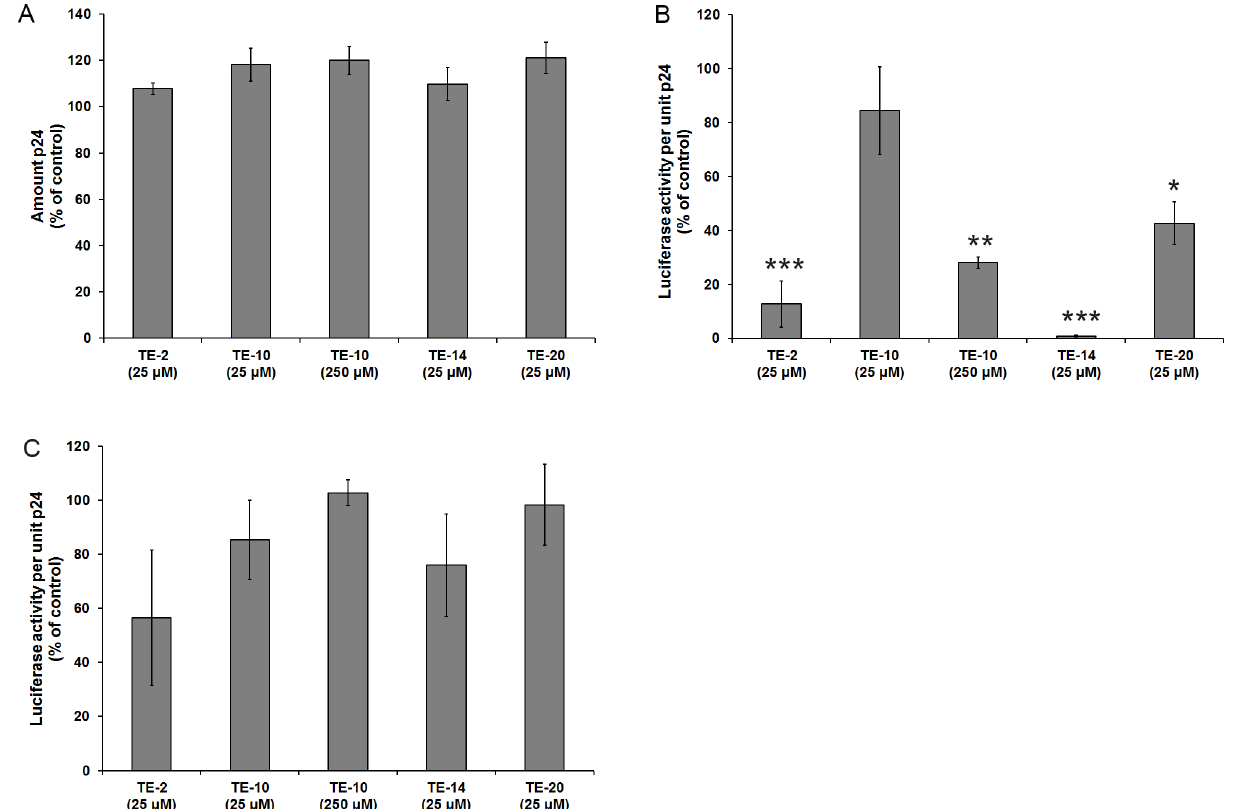
Fig 7. Effect of the organotellurium compounds on HIV-1 production in persistently HIV-1 infected ACH-2 cell cultures. (A) Amount of produced virus measured by p24 production: Persistently HIV-1-infected ACH-2 cells were cultured in the presence of 100 nM PMA and 25 μ M of the indicated test compound (also 250 μ M for TE-10). After 3 days, the supernatant was clarified and the amount of p24 was measured by ELISA. The value for the control was set to 100% in each individual experiment and all other values were normalised against these reference values. The data are means of three independent experiments; the error bars represent the SEM. P-values are indicated if significant ( * : p < 0.05; ** : p < 0.01; *** : p < 0.001).(B) Infectivity of the produced virus particles per unit p24: The clarified supernatant of the drug-treated ACH-2 cell cultures were further used for an infectivity test in TZM-bl cell cultures (without the addition of any compound). TZM-bl cells were infected with the diluted virus supernatants in a total volume of 0.2 ml DMEM (eventual dilution of virus supernatant: 1:100). After 40 h, the cells were assayed for luciferase activity. The value for the control was set to 100% in each individual experiment and all other values were normalised against these reference values. The data are means of three independent experiments; the error bars represent the SEM. P-values are indicated if significant ( * : p < 0.05; ** : p < 0.01; *** : p < 0.001).(C) Control experiment: A control experiment was performed, in which virus particles produced without the addition of compound, were used for an infectivity test. The same amount of compound that could have been carried over with the virus containing supernatant in the original experiment (Panel B) was added to the infectivity test (final concentration: 1/100 of the indicated amount in the viral growth culture). The value for the vehicle control (DMSO) was set to 100% in each individual repeat and all other values were normalised these reference values. The data are means of three independent experiments; the error bars represent the SEM. P-values are indicated if significant ( * : p < 0.05; ** : p < 0.01; *** : p <